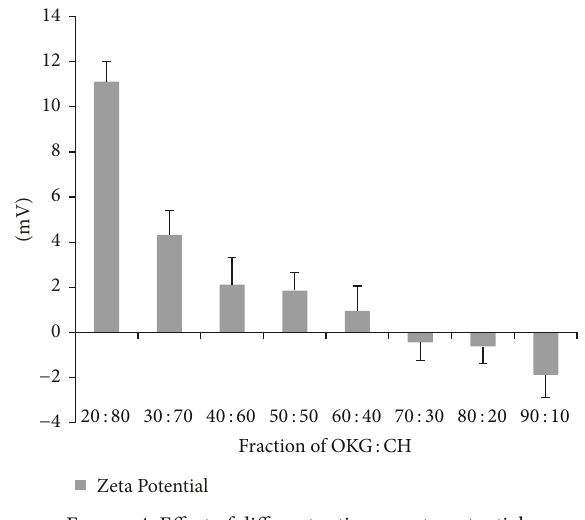
Figure 4: Effect of different ratios on zeta